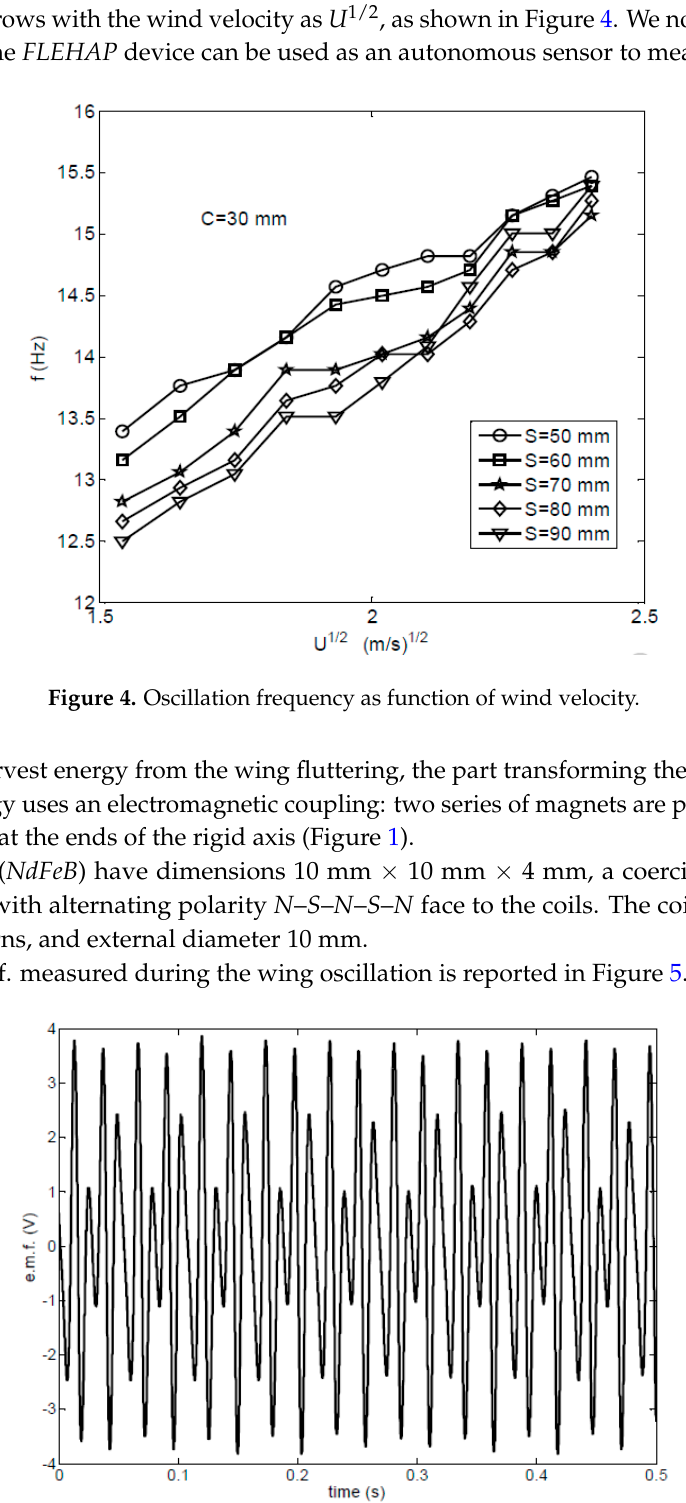
Figure 5. Electromotive force (e.m.f.) measured at the end of the coils with a wing of chord = 40 mm and span = 70 mm in a wind of 5 m/s.